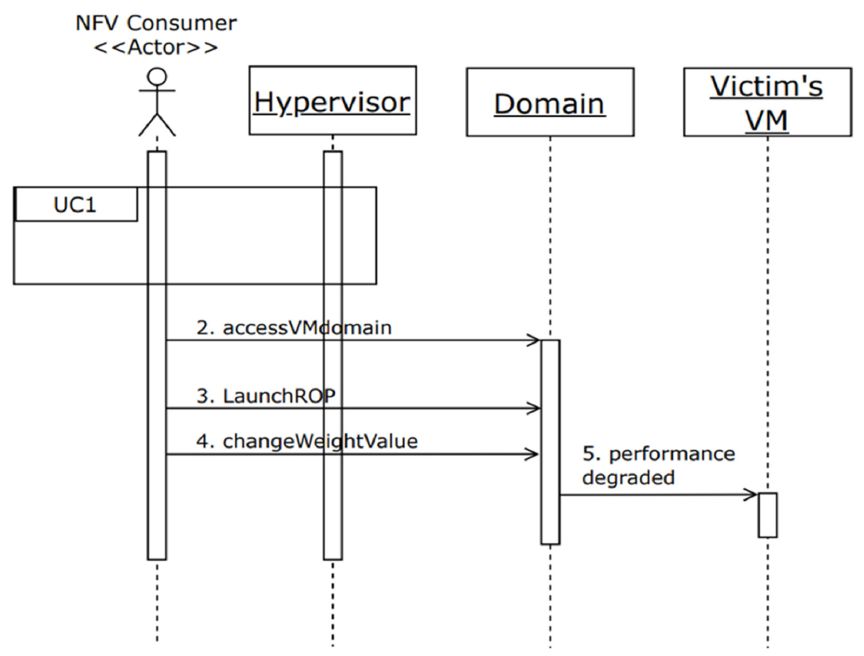
Figure 4. Sequence diagram for use case “Degrade the performance of the victim’s network